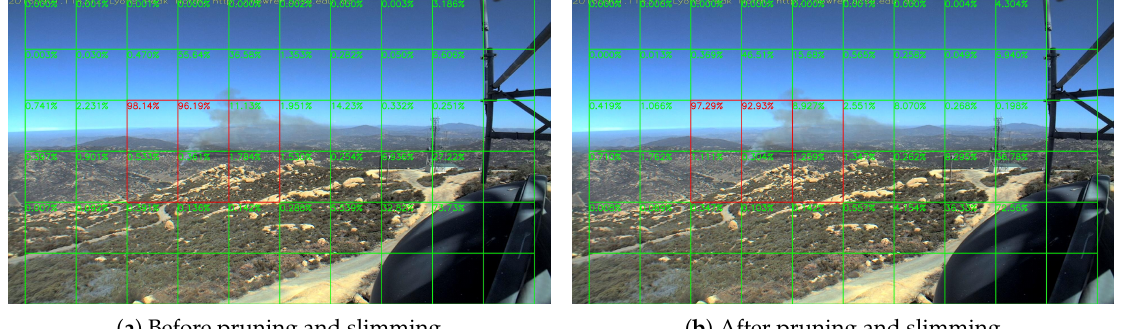
Figure 7. Lyons Fire in San Diego, 1 September